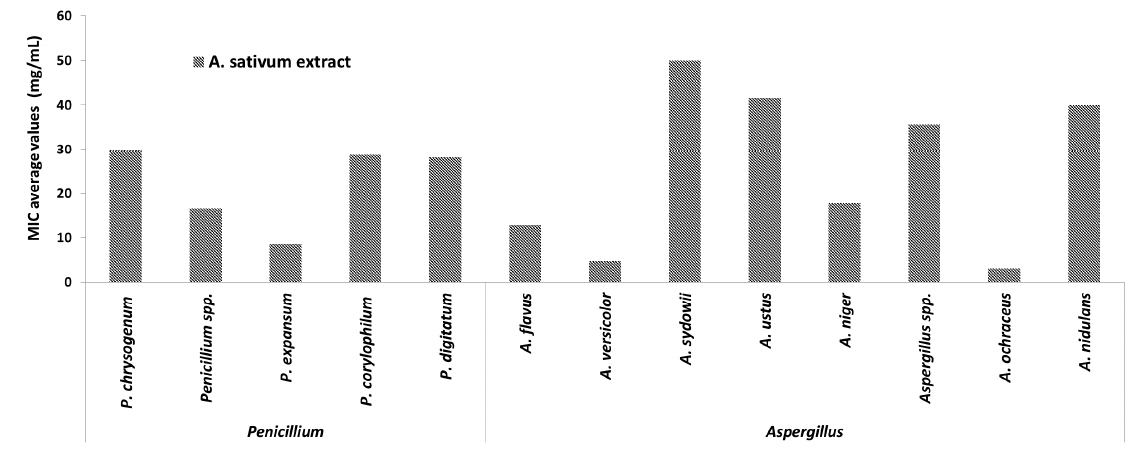
Figure 6. Average values of minimal inhibitory concentration (MIC) of A. sativum extract obtained on the tested fungi.